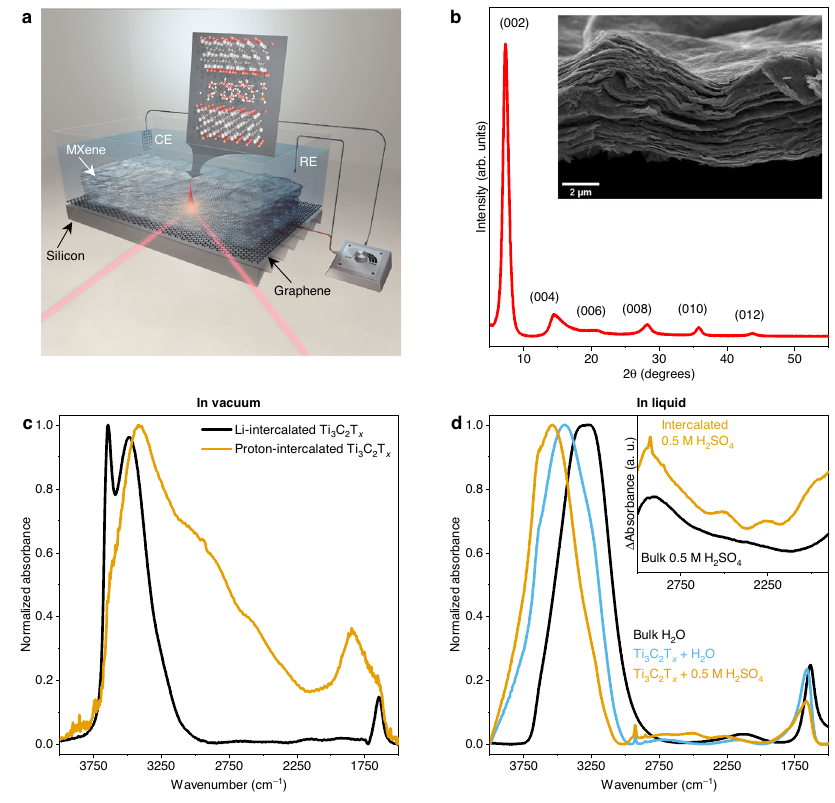
Fig. 1 | Probing con fi ned water and protons within Ti 3 C 2 T x MXene interlayers. a Schematic of the operando ATR-FTIR spectroscopy cell with a thin Ti 3 C 2 T x fi lm drop casted on a graphene-coated silicon wafer and used as a working electrode. Platinum and silver wires were used as counter and reference electrodes, respec- tively (CE and RE). The inset represents the Ti 3 C 2 T x MXene unit cell used for the density functional theory (DFT) calculations. b XRD pattern and scanning electron microscopy (SEM) image (inset) of a freestanding Ti 3 C 2 T x fi lm. c Normalized FTIR